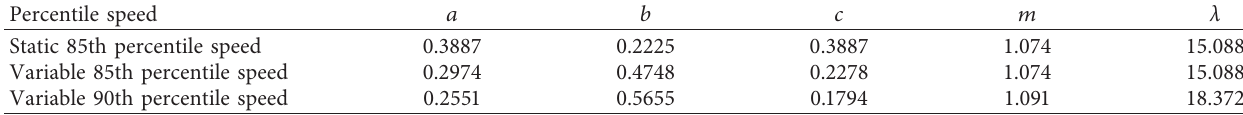
Table 3: Undetermined coefficients of EWM with different speed limit methods.